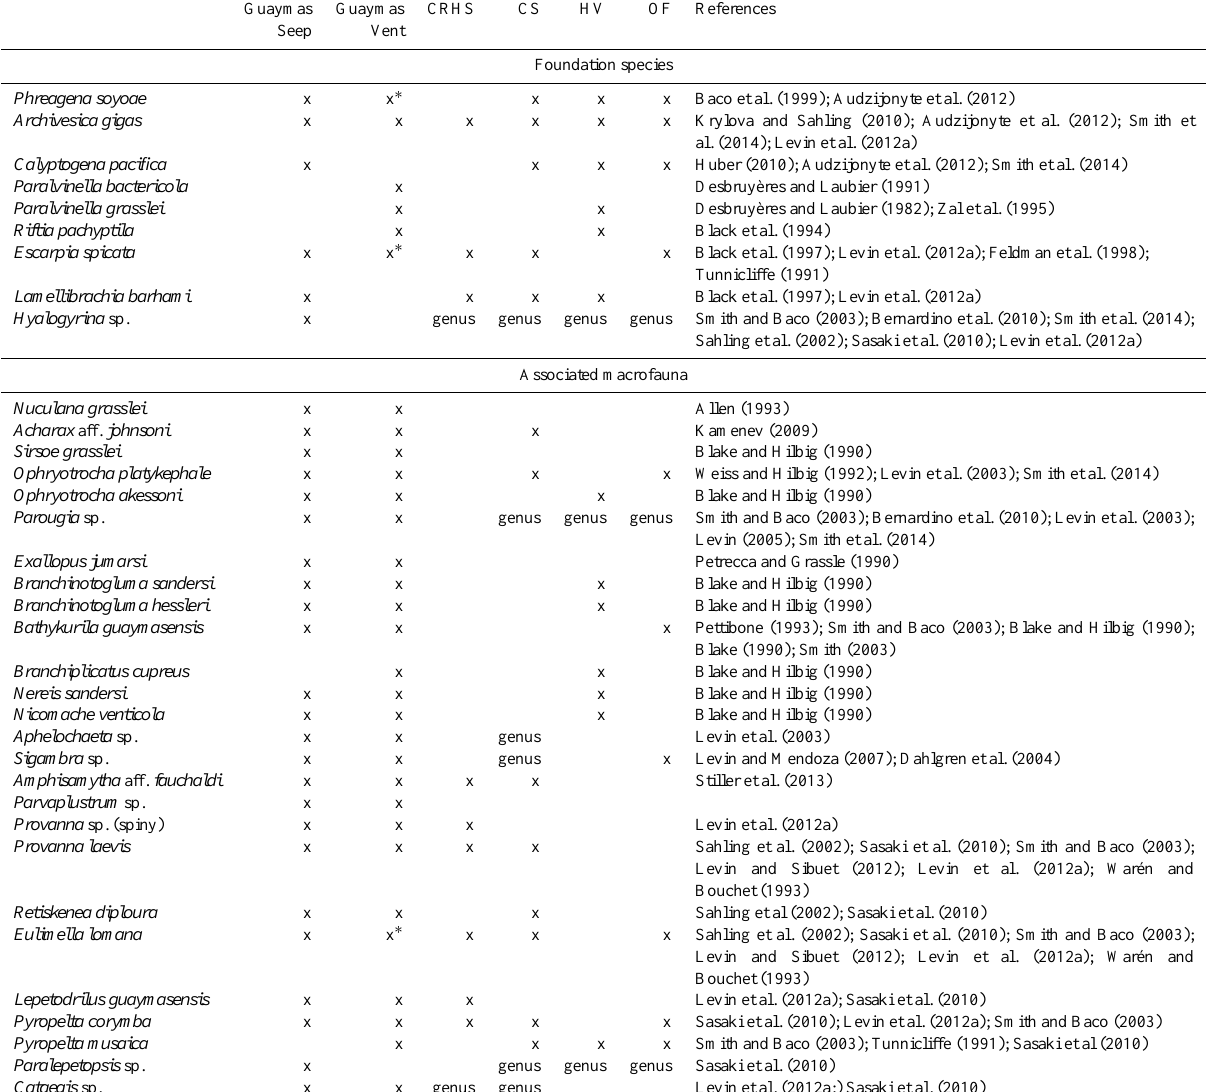
Table 7. Presence or absence of seep and vent species in the Guaymas Basin ( ∗ : species not found within our study but previously recorded in Guaymas vents) and species records from other studies in the Costa Rica “hydrothermal seep” (CRHS) and, more generally, at cold seeps (CS), vents (HV) or organic falls (OF) around the